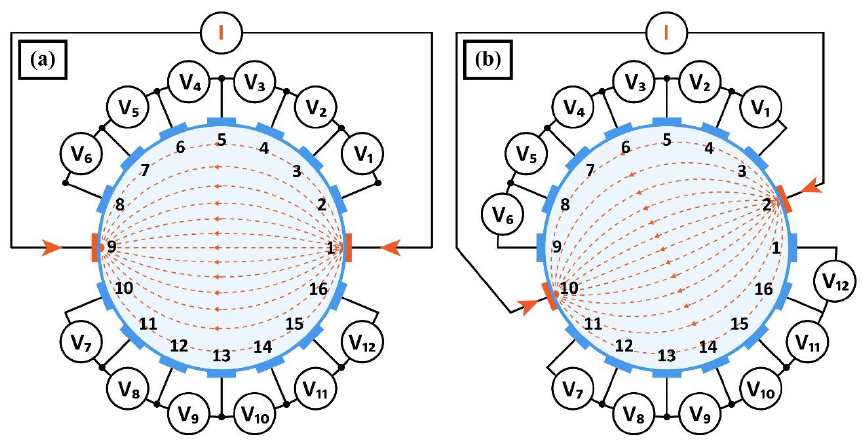
Figure 5. Voltage measurement method. (a) first measuring cycle, (b) second measuring cycle.